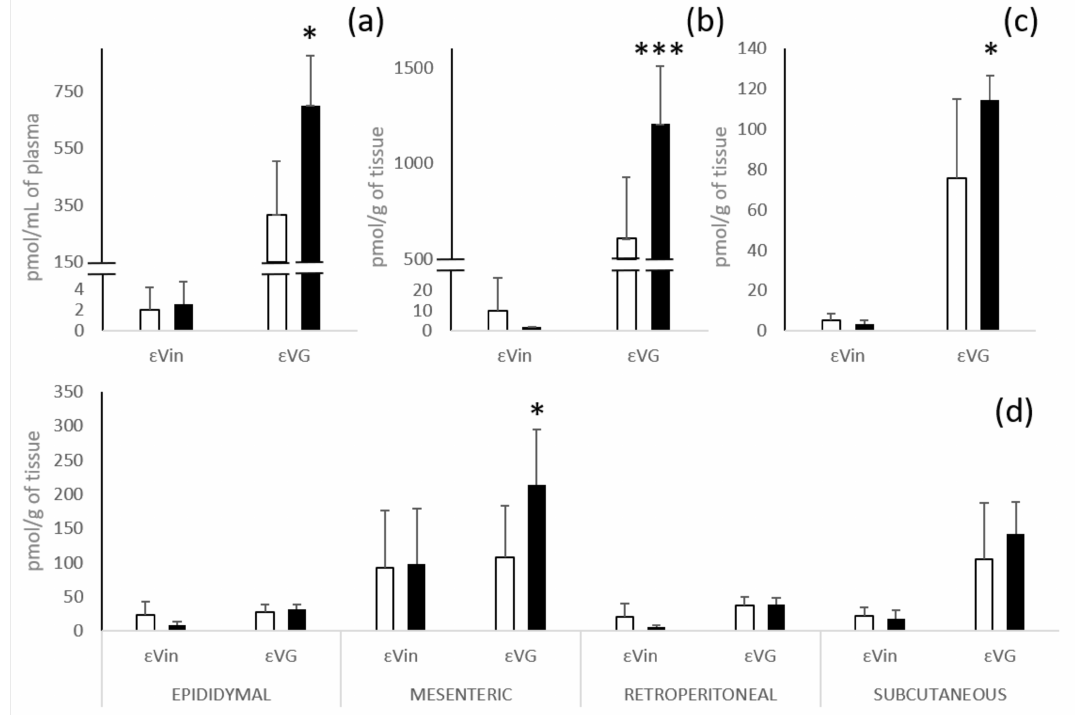
Figure 3. Quantification of ε Vin and ε VG in plasma ( a ); liver ( b ); kidneys ( c ); and different white adipose tissues ( d ) 4 h after oral administration of 20 mg/kg bw of ε Vin in free (white bars) or encapsulated (black bars) forms. Bars represent concentrations expressed at pmol/mL for plasma and pmol/g of tissue for tissue + SD. Comparisons between encapsulated or free form administration were analyzed by Student’s t -test (* p < 0.05; *** p <